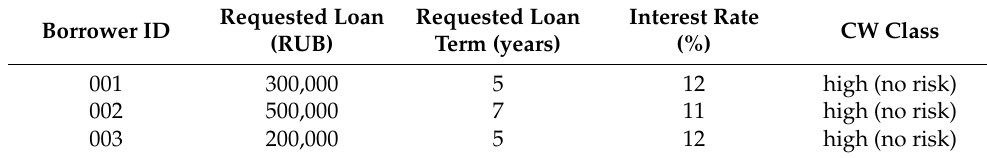
Table 12. Step 3: determination of the borrower’s CW.